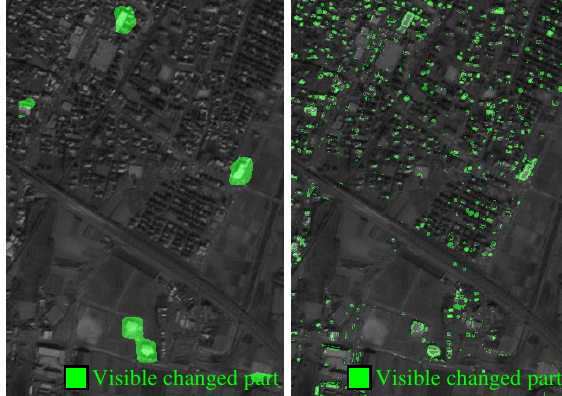
Figure 3: Pixel-change images overlayed with 2 nd orthoimage using 25 pixels square window (right) and 3 pixels square window (left)